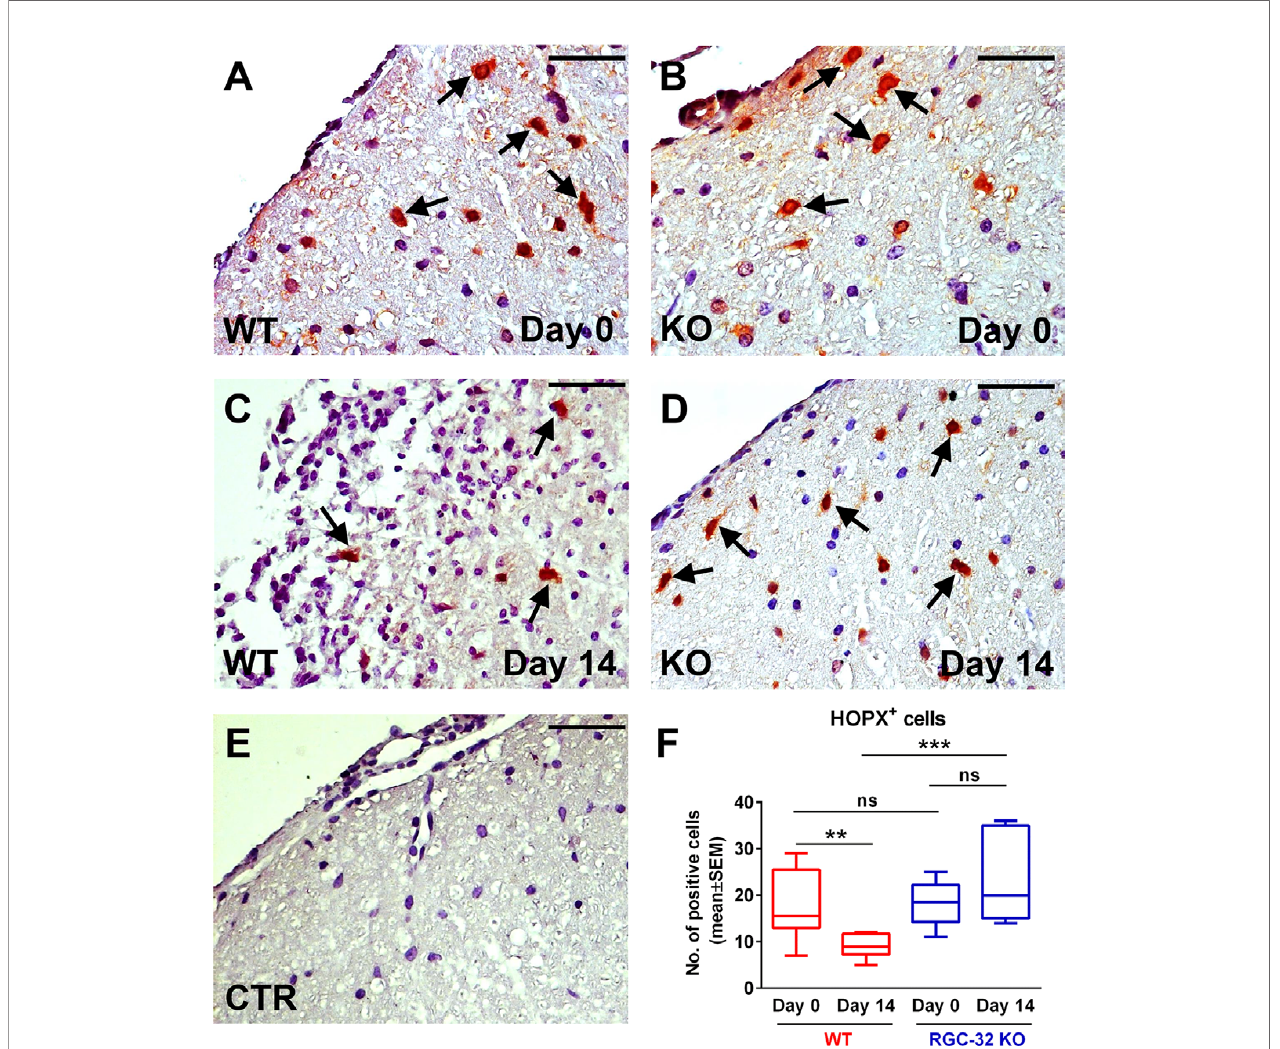
FIGURE 11 | Lack of RGC-32 affects the number of HOPX + spinal cord radial glia in vivo during the acute phase of EAE. Cervical spinal cords were harvested from uninjected mice (day 0) and from mice with EAE on day 14, stained with an anti-HOPX antibody, and then counterstained with Harris hematoxylin. On day 0, HOPX + cells were distributed with a relatively equal density in WT and RGC-32 KO mice (A, B) , arrows. However, on day 14, the number of HOPX + cells was signi fi cantly higher in RGC-32 KO mice (D) , arrows than in WT mice (C) , arrows. In WT mice, we detected fewer HOPX + cells on day 14 than on day 0, whereas in RGC-32 KO mice we did not detect any noticeable difference between day 0 and day 14. The control (CTR) for the immunoperoxidase reaction was negative (E) . Original magni fi cation: x40. Scale bars: 20 µm. Counting the total number of HOPX + cells per microscopic fi eld revealed no difference between WT and RGC-32 KO mice on day 0, and a signi fi cantly higher number in RGC-32 KO mice than in WT mice on day 14 (F) . Results in (F) are expressed as mean ± SEM. Day 0: N = 3 mice (8 microscopic areas) in each group. Day 14: N = 3 mice (8 microscopic areas) in each group. **p < 0.01; ***p < 0.001; ns, not statistically signi fi cant (Kruskall-Wallis test with Dunn ’ s multiple comparisons